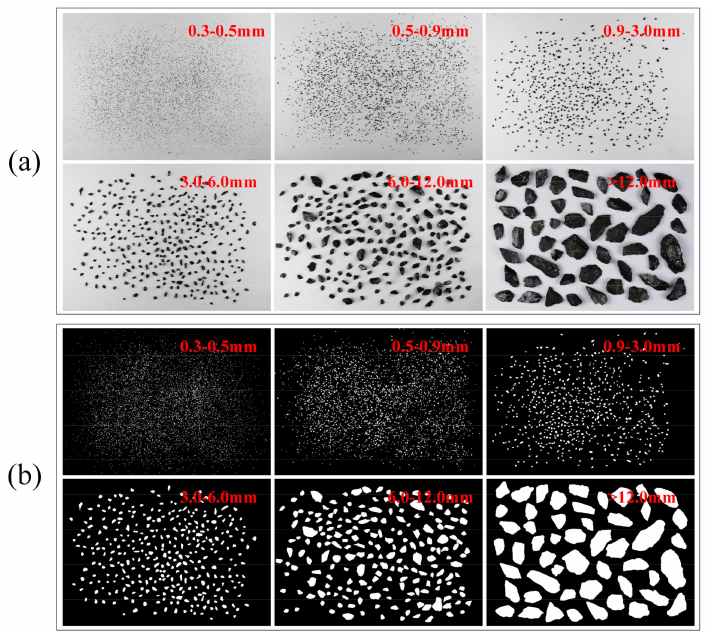
Figure 4. Determination of fragment size and shape distributions using the image processing method.